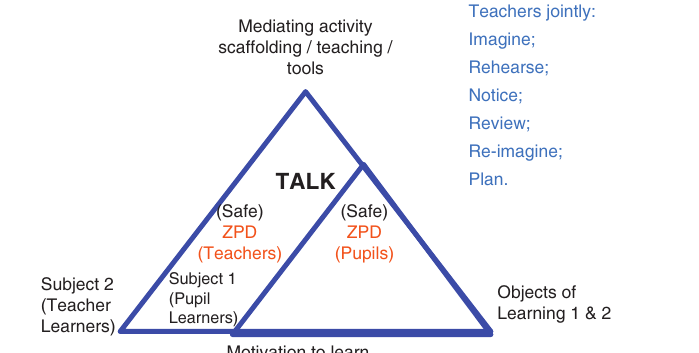
Figure 3: Activity theory integrating teacher learning with student learning in contexts of RLS